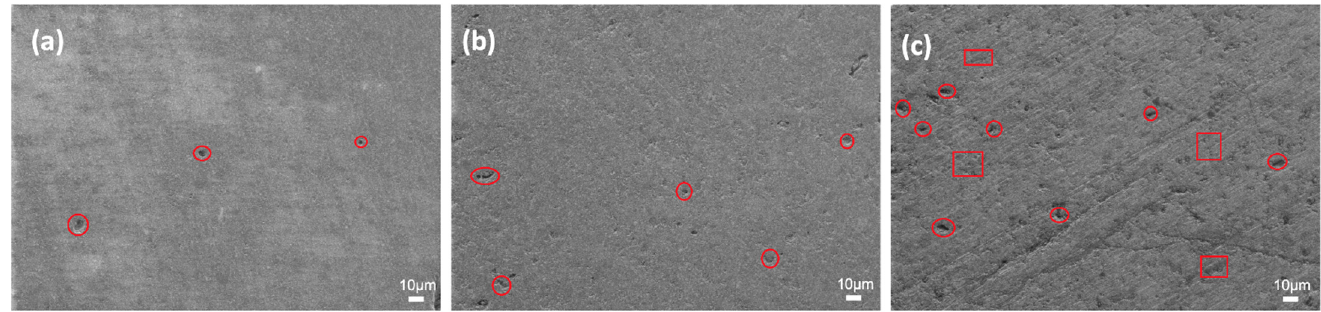
Figure 6. SEM images of the sintered glass-ceramics at 1.00 KX: ( a ) 30Zr-Ar, ( b ) 40Zr-Ar, and ( c ) 50Zr-Ar. The 30Al-O, 40Al-O, 30Zr-Ar, and 40Zr-Ar samples were subjected to EDS analysis. Figures 7 and 8 show the SEM/EDX analyses of the selected samples, while Figures S3–S8 (in the supporting information file) present the analyses of the other samples. All meas- urements of the composites with Al 2 O 3 additive yielded the elements Al, Si, B, and O. The homogenous distributions of the Al, Si, B, and O elements are visible in the glass–Al 2 O 3 composite of 30Al-O (Figure 7). The primary difficulties seen in conventional glass-ce- ramic processes, such as a lack of well-distributed particles, the emergence of clustered